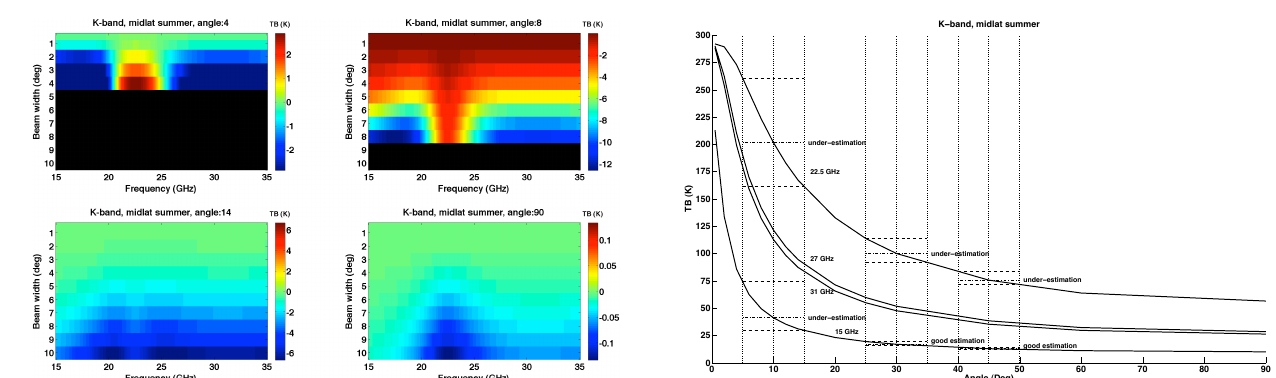
Fig. 11. The errors associated to the antenna beam width effect in differential TB for K-band frequencies using the mid-latitude sum- mer atmospheric profile. The TB differences are defined as the TB Figure 11. The errors associated to the antenna beam width effect in factional opacity for K-6 calculated from a forward model without beam width minus the TB band frequencies using the mid-latitude summer atmospheric profile. The TB differences are 7 calculated from a forward model with beam width. Black area at defined as the TB calculated from a forward model without beam width minus the TB 8 elevations 4 ◦ and 8 ◦ are when the beam at least partially hits the calculated from a forward model with beam width. Black area at elevations 4° and 8° are 9 ground. when the beam at least partially hits the ground. 10